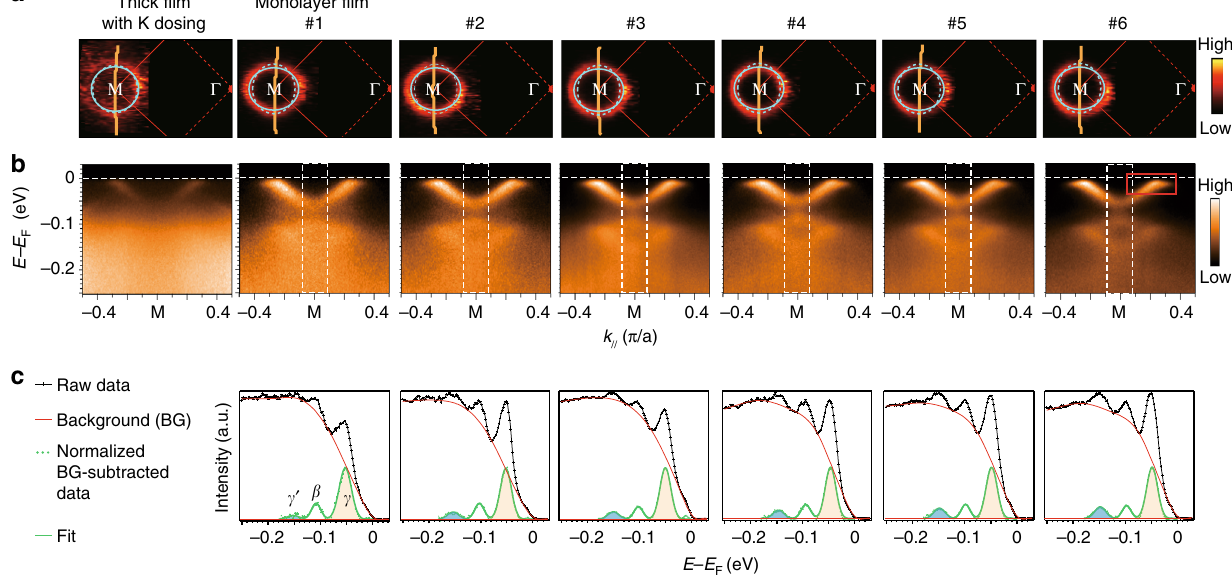
Fig. 2 Side-band intensity in FeSe thick fi lm and various 1 ML FeSe/ST 16 O samples. a Photoemission intensity maps at the Fermi energy, and b photoemission intensity distributions across M along the cut illustrated in panel a , of various samples, including a K-dosed thick fi lm and 1 ML FeSe/ST 16 O samples #1 – #6. c EDCs around M, the background used in intensity analysis, background-subtracted photoemission intensity normalized by the peak height of the γ ′ band, and the corresponding fi ts for samples #1 – #6. For better statistics, the EDCs are integrated over the momentum range indicated by the white dashed rectangle in panel b . The background is modeled using a cubic spline interpolation. The data (dots) are fi tted to three Gaussian peaks, representing the spectral weight from the γ , β , and γ ′ bands ( γ * and γ ′ have low spectral weight and are neglected here). Details of the background modeling and fi tting are shown in Supplementary Figure 4. The spectral weights of bands γ and γ ’ are denoted as I 0 and I 1 , respectively. The variation of the replica band intensity ratio is not related to the slight variation of the background (Supplementary Figure 5). As the intensity ratio I 1 / I 0 decreases from sample #6 to sample #1, the replica band γ ′ always has the same full-width at half-maximum as that of the main band γ and does not smear out (Supplementary Figure 6). All data were measured at 6 K